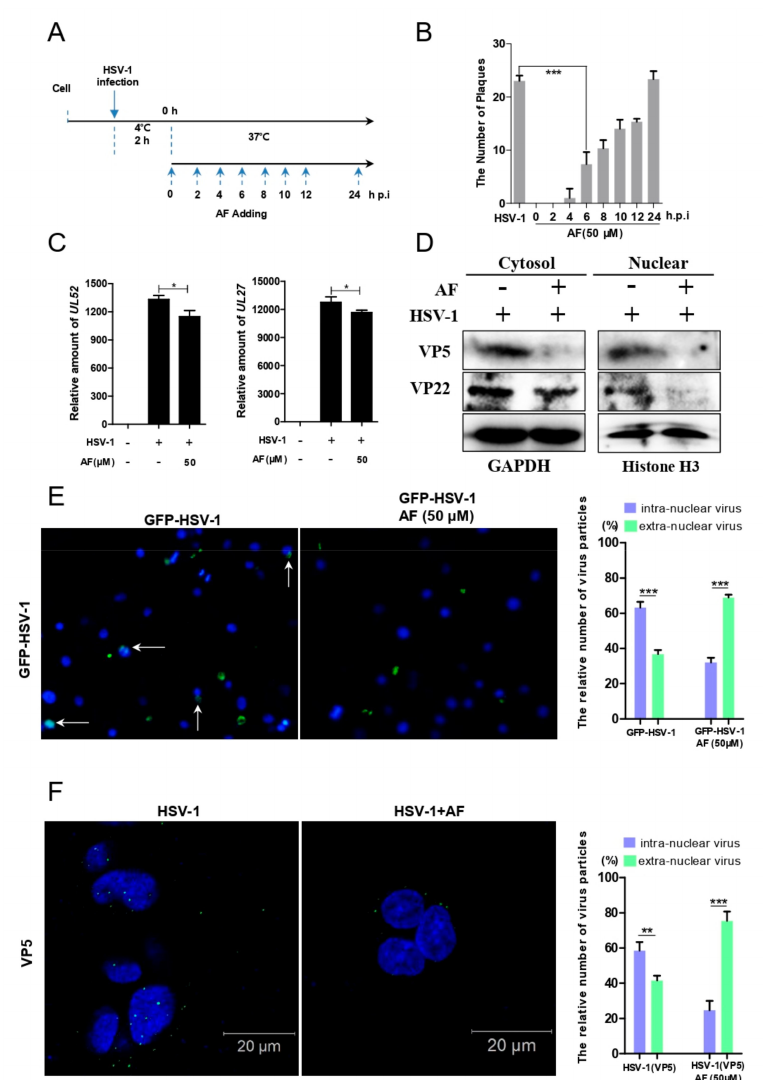
Figure 5. Amentoflavone impairs the viral nuclear transport process. ( A ) Simple diagram of the time-addition assay. ( B ) Vero cells were treated with HSV-1 (MOI = 0.1) at 4 ◦ C to adsorb. After 2 h, the cells were washed with PBS to remove the virions and were subsequently incubated at 37 ◦ C. Then, amentoflavone was added at di ff erent time points. After 72 h, the cells were fixed and strained with crystal violet dye. Data are mean ± SD ( n = 3), *** p < 0.001. ( C ) The cells were challenged with HSV-1 (MOI = 10) at 4 ◦ C for 2 h, and were treated with amentoflavone for another 2 h. The total DNA was extracted, and the expression level of UL52 and UL27 was detected. Data are mean ± SD ( n = 3), * p < 0.05. ( D ) The cells infected with HSV-1 (MOI = 10) for 2 h at 4 ◦ C were treated with amentoflavone (50 µ M) or DMSO (control group) for another 2 h at 37 ◦ C, and the total proteins in the cytoplasm and nucleoplasm were extracted. The protein levels of viral proteins VP5 and VP22 were analyzed by western blot assay. ( E ) Vero cells were challenged with GFP-HSV-1 (MOI = 10) at 4 ◦ C for 2 h, and were treated with amentoflavone or DMSO (control group) for another 2 h at 37 ◦ C. The cells were then fixed and the immunofluorescence images were acquired by a Nikon microscope. In addition, the number of intra / extranuclear virus particles was counted in 100 fields. White arrows indicated the GFP-labeled HSV-1 virion within nucleus. Data are mean ± SD ( n = 3), *** p < 0.001. ( F ) SK-NSH cells were infected with HSV-1 for 2 h at 4 ◦ C and were treated with amentoflavone or DMSO (control group) for another 2 h at 37 ◦ C. The cells were then fixed and stained with anit-VP5 primary antibody (green) and DAPI (blue). The immunofluorescence images were acquired by a confocal LSM. Data are mean ± SD ( n = 3), ** p < 0.01, *** p <